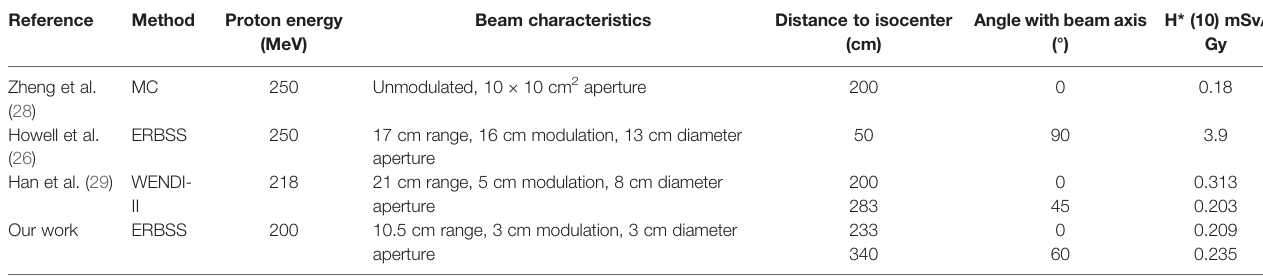
TABLE 5 | Comparison of H* (10) with other